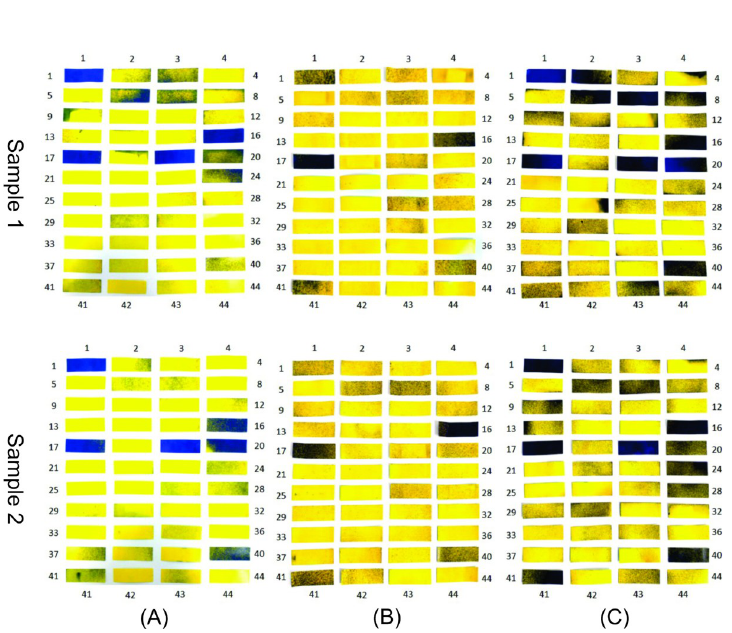
Fig 10. WSPs applied to the body of an individual properly dressed in PPE and exposed to the biocidal agent in the disinfection chamber composed of six nozzles. (A) Exposure for 10 s without turning in the central area of the chamber; (B) exposure for 10 s with 360˚ rotation in the central area of the chamber; (C) exposure for 30 s with 360˚ rotation in the central area of the chamber.